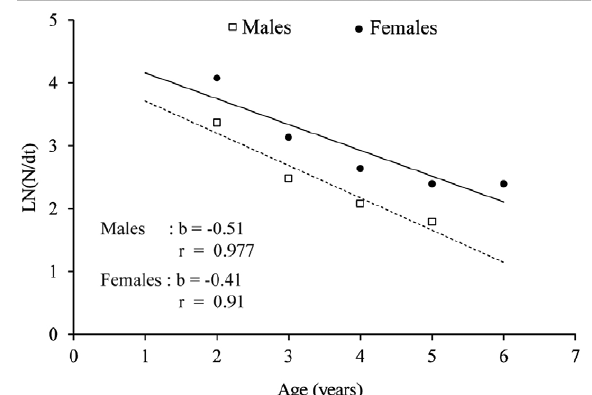
Fig. 4. – Relation between otolith radius (Ro) and total length (TL) of Sciaena umbra in the Gulf of Tunis.